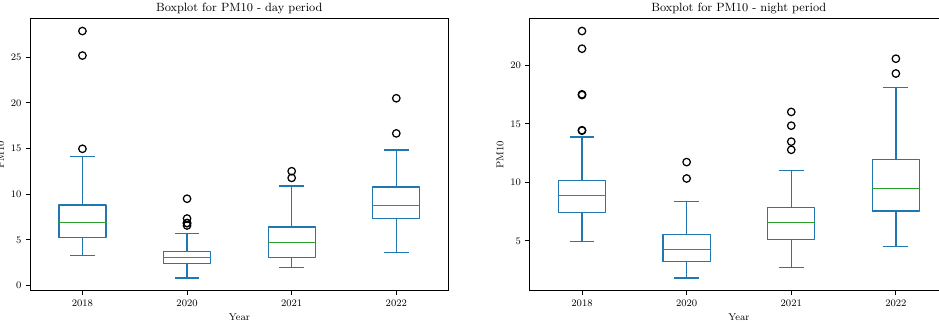
Figure 6. Boxplots for PM10 for daytime ( left ), and night-time ( right ) for the data in the observed period.